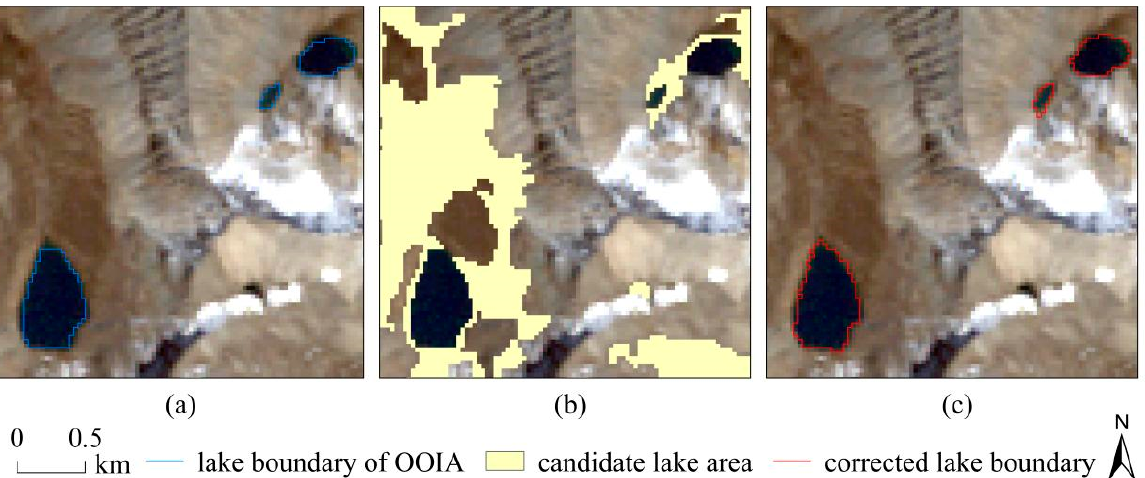
Figure 10. Results of each stage of extraction process: ( a ) result of the object-oriented method; ( b ) candidate lake area obtained by the object-oriented method; ( c ) the result after the correction of the lake boundary.